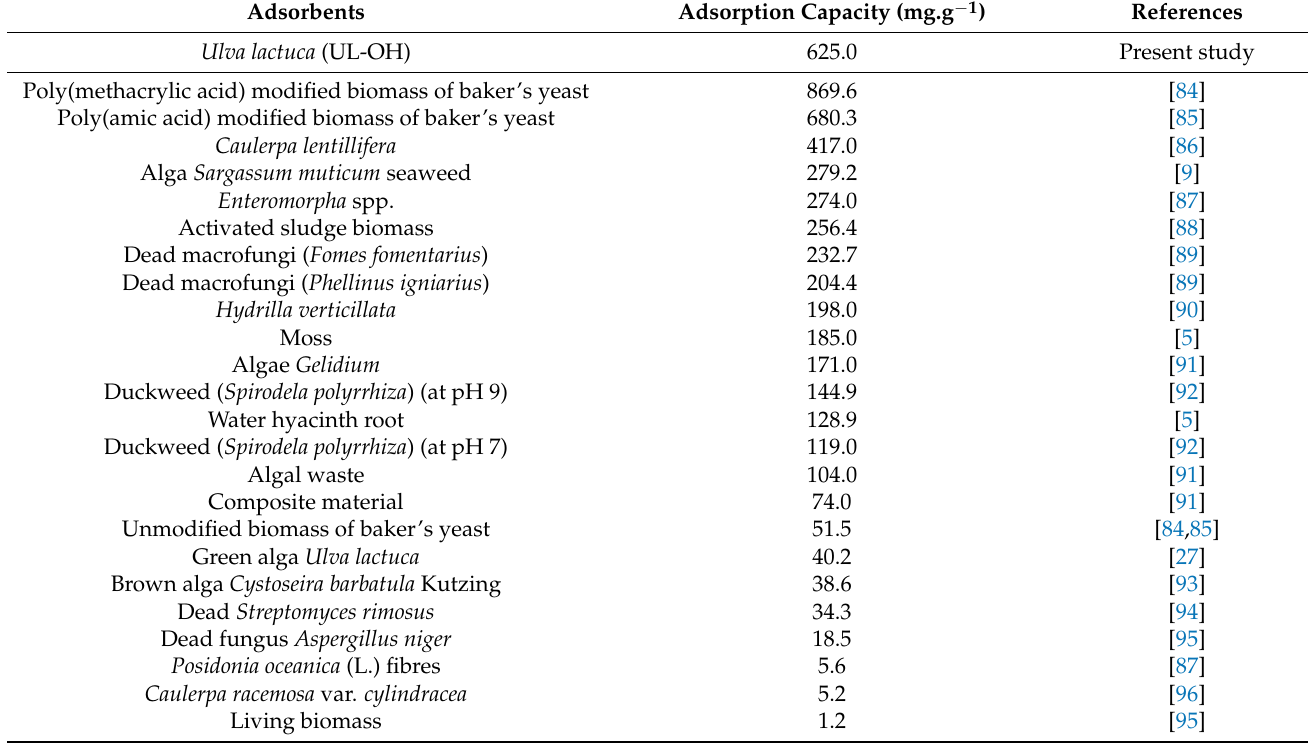
Table 7. Adsorption capacities of adsorbents for the removal of MB based on the review of Rafatullah et al. [83].